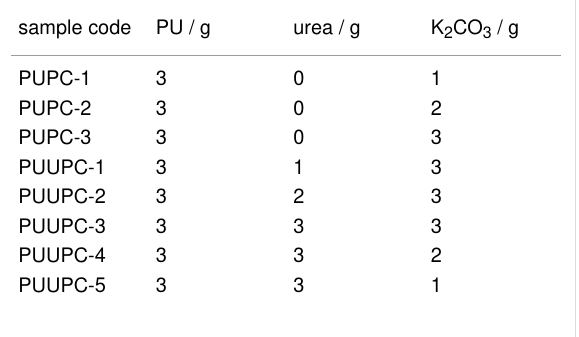
Table 3: Sample code and amounts of PU, urea and K 2 CO 3